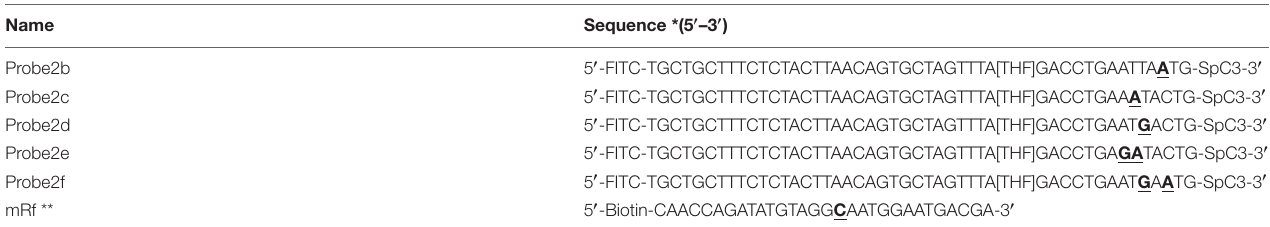
FIGURE 7 | Introduction of mismatches into the primer-probe set. The original primer–probe set probe2/reverse primer had five consecutive matching bases and could form a primer–probe complex that finally gave false-positive signal (a) . One base substitution made on the probe at different positions could not disrupt the consecutive base matching and gave false-positive signals (b–d) . The probe with two base substitutions still formed a three-consecutive base matching with reverse primer and gave false-positive signal (e) . Simultaneous three base substitutions, two on the probe and one on the reverse primer, avoided this matching and gave no product/signal (f) . Labels and modifications on DNA, nfo, base matching, as well as mismatching are indicated with different shapes and colors, with the legends given at the bottom of the figure. TABLE 5 | Base substitutions in Probe2 and the reverse